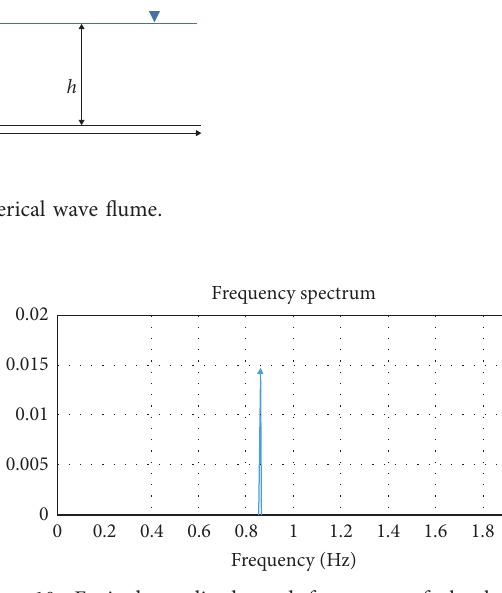
Figure 10: Excited amplitude and frequency of the heaving pontoon at Ak � 0 . 05 and kb � 0 . 7. Table 4: Amplitude and frequency of the heaving pontoon in Case 1.